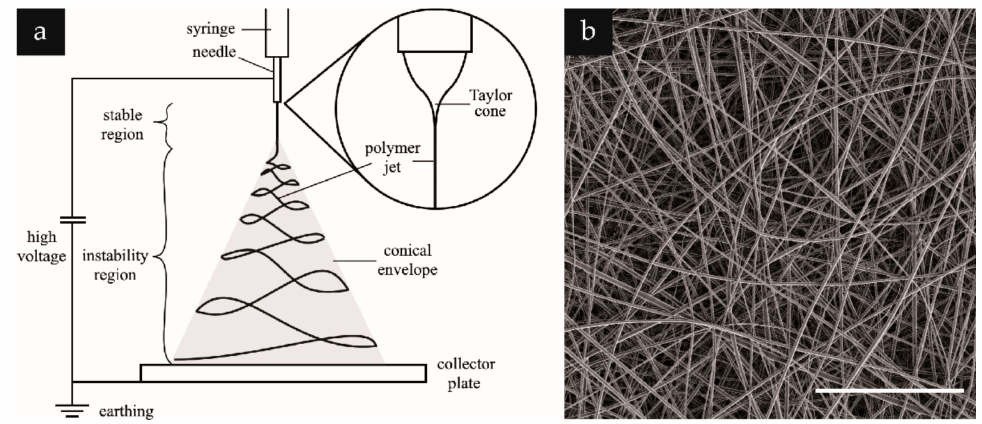
Figure 1. ( a ) Scheme of basic electrospinning setup with three major components: a needle contacted by an electrode, a high voltage source, and a grounded collector plate. Applying a sufficiently high voltage at the needle, after a droplet of polymer solution or melt has formed at its tip, results in a jetting thereof. The path of the jet is straight near the needle; however, it quickly turns chaotic due to bending instabilities but is nevertheless confined within a conical envelope visible using long exposure photography [11]. During the flight, jets are stretched, yielding thin diameters, facilitating the evaporation of the solvent and accelerating the formation of fibers. The fibers accumulate on the collector in a random orientation, resulting in a nonwoven mat. Figure self-drawn. ( b ) SEM of a typical cellulose acetate nonwoven mesh resulting from such a basic electrospinning setup. Scale bar = 20 µ